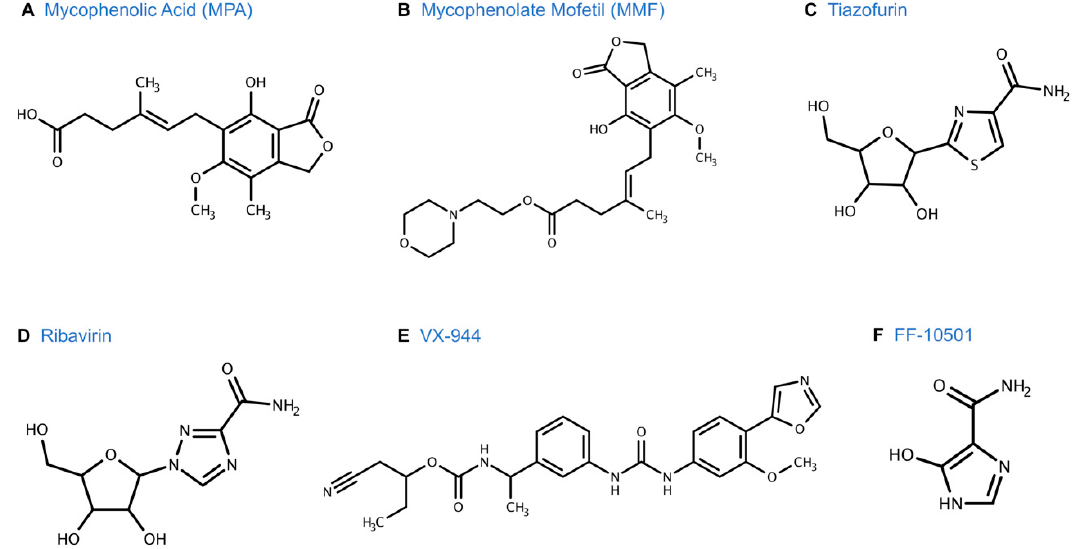
Figure 4. MPA and other IMPDH inhibitors and chemical structures.